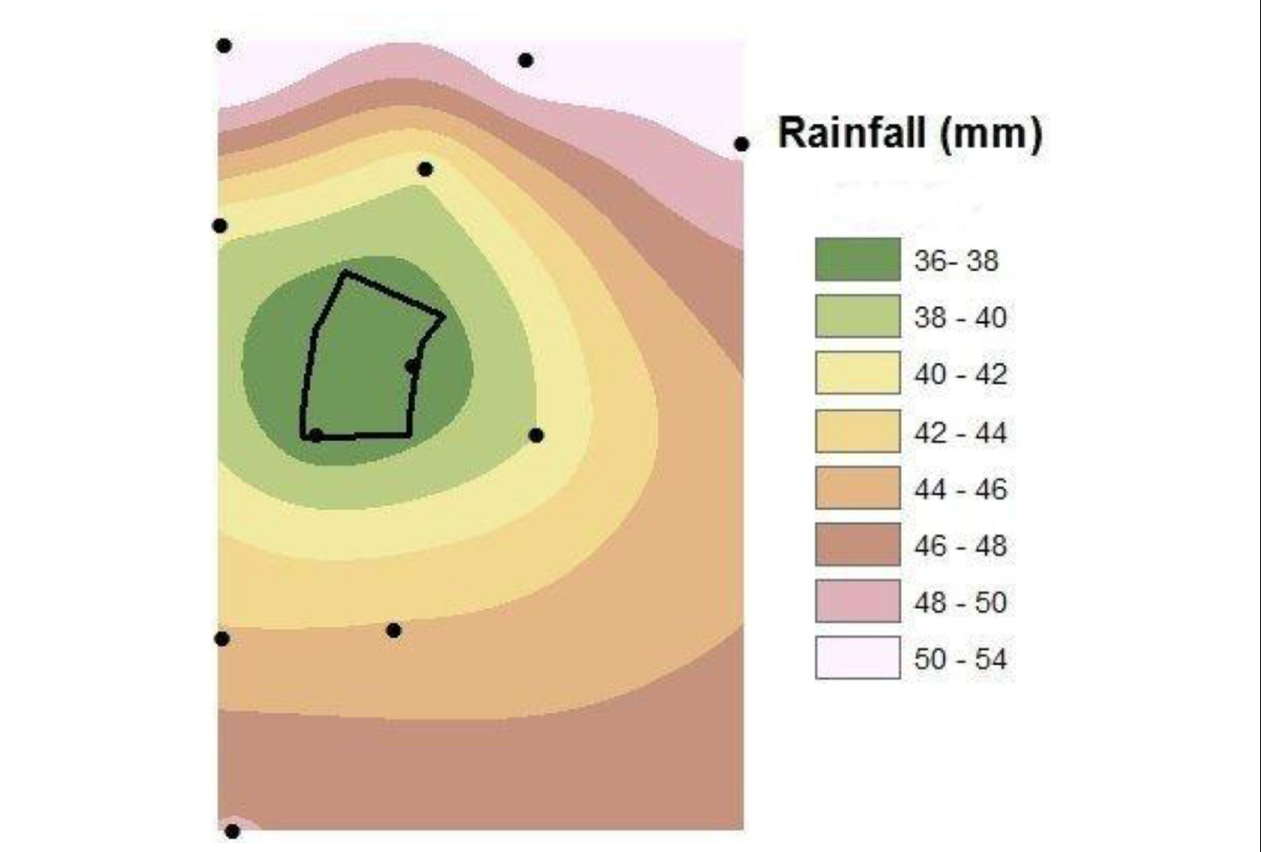
FIGURE 2 | The distribution of rainfall from rainfall event on September 7, 1996 among the 11 rain gauges on the research farm. The rain gauges are defined by black circles. The six runoff plots are delineated by the thick black line. The rain fall volumes were plotted to the geographic position in ArcMap and the distribution was determined by interpolation using the Kriging